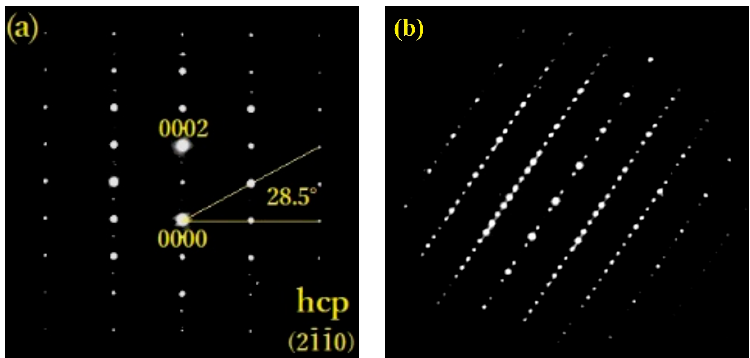
Figure14. TEManalysisonjointtypeB(1100J);di ff ractionpattern(DP)of( a )Mgmatrix; ( b )intermetallic Figure 14. TEM analysis on joint type B (1100 J); diffraction pattern (DP) of ( a ) Mg matrix; ( b ) compound (IMC) particles, at the interface centerline intermetallic compound (IMC) particles, at the interface centerline region.